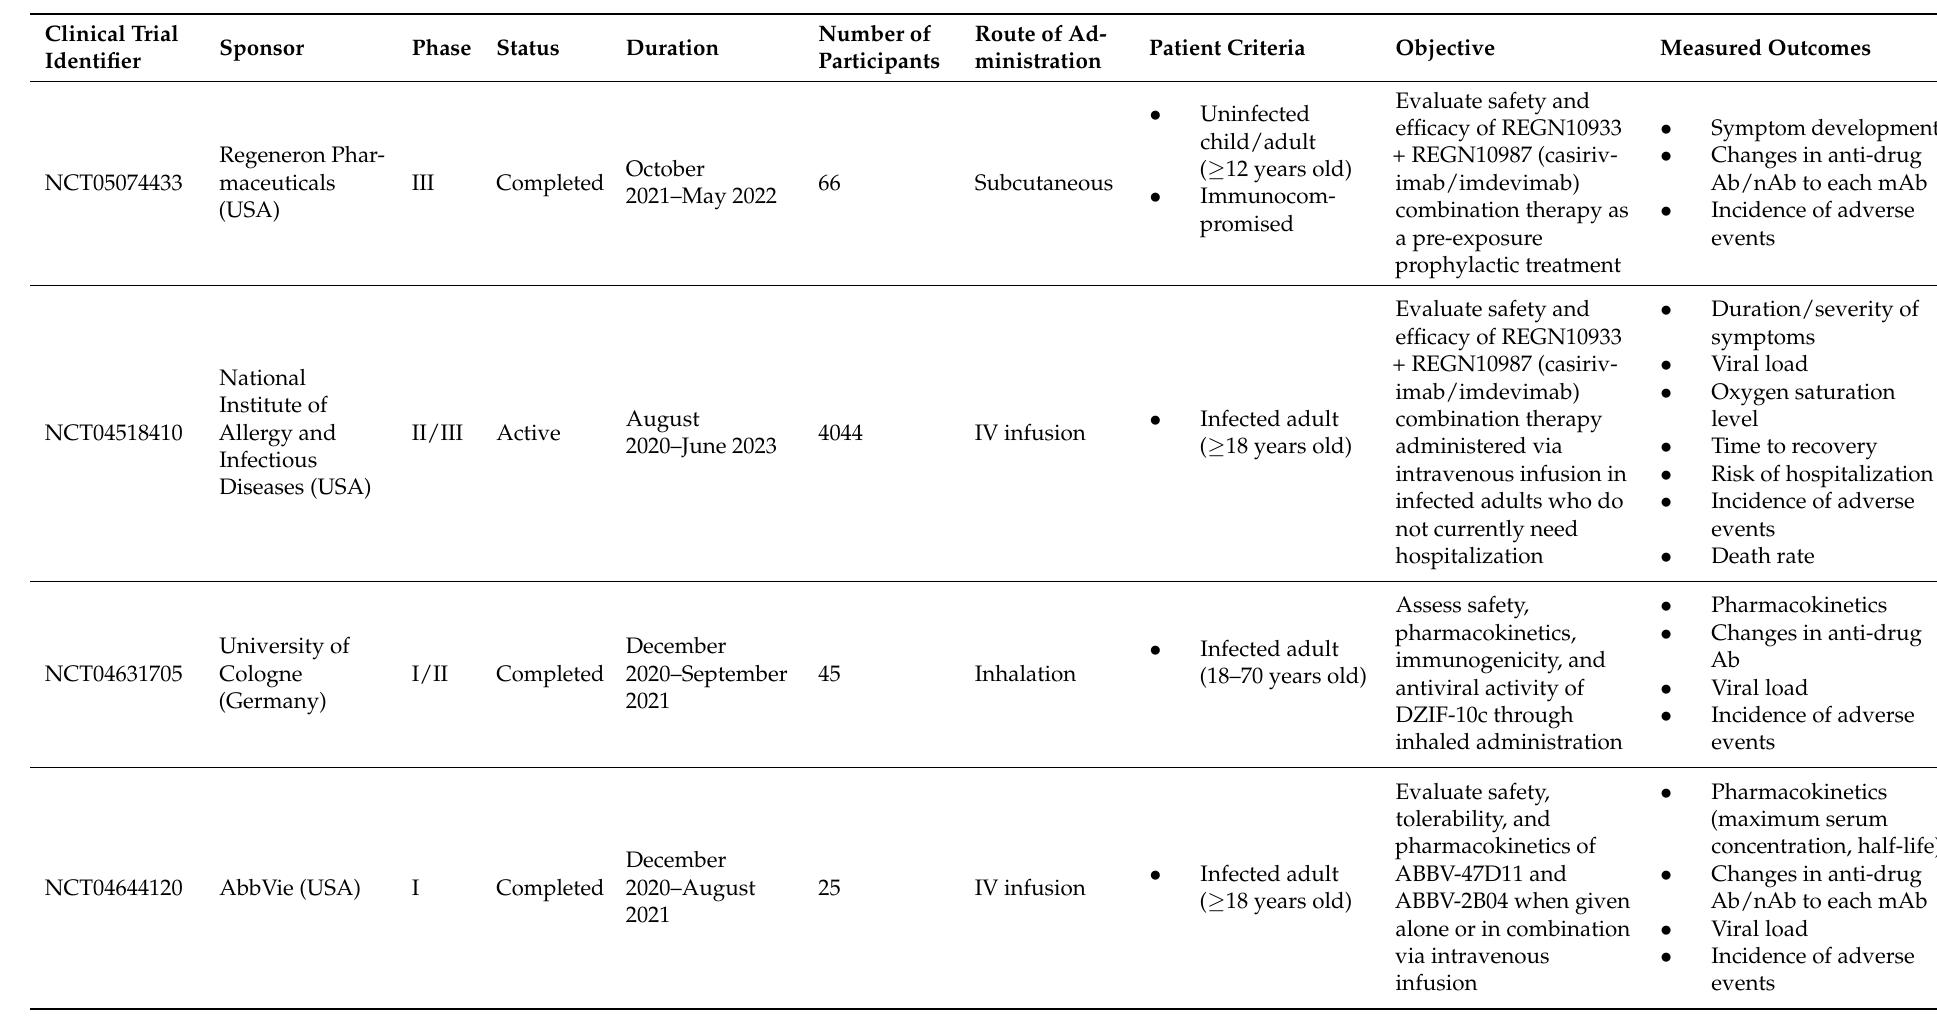
Table 3. Clinical trials on monoclonal antibodies as therapeutic strategy against